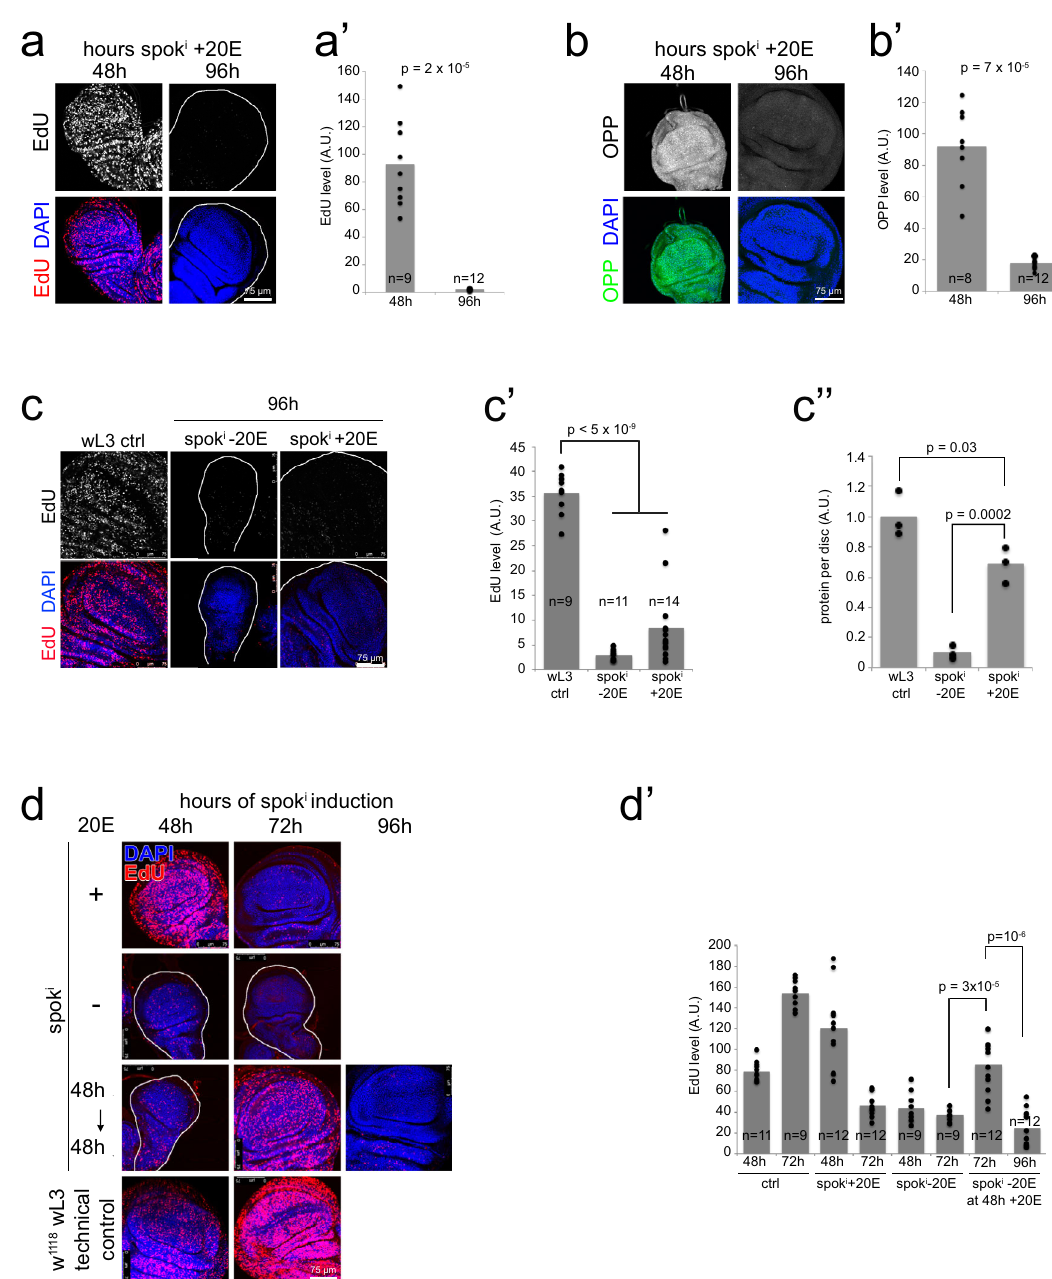
Fig. 1 Exogenously controlled ecdysone signaling enables wing discs to fi rst proliferate and then terminate growth and proliferation. a – b ’ Tub ts > spok i + 20E discs fi rst proliferate ( a – a ’ ) and grow ( b – b ’ ) robustly and then stop. a – a ’ Proliferation, assayed by EdU incorporation, for spok i discs 48 or 96h after knockdown induction and 20E feeding. Representative images in ( a ), quanti fi ed in ( a ’ ). Representative of six biological replicates. b – b ’ Growth, assayed via O-propargyl-puromycin (OPP) incorporation into nascent polypeptide chains, 48 or 96 h after knockdown induction and 20E feeding. Representative images in ( b ), quanti fi ed in ( b ’ ) Representative of three biological replicates. c – c ” Tub ts > spok i + 20E discs grow 10-fold in size and then terminate proliferation at a size similar to those of control wing discs at the end of third instar larval development. Proliferation is assayed by EdU incorporation, representative images in ( c ), quanti fi ed in ( c ’ ) and size is assayed as total protein per disc by BCA protein measurement ( c ” , n = 3×2 technical duplicates on 6 wing discs). d – d ’ Discs proliferate beyond the 48 h timepoint if 20E feeding is delayed. EdU incorporation at indicated times after spok i induction for larvae not fed ecdysone ( − 20E), fed ecdysone as of knockdown induction ( + 20E) or fed ecdysone starting 48 h after knockdown induction (48h − → 48 h + ).